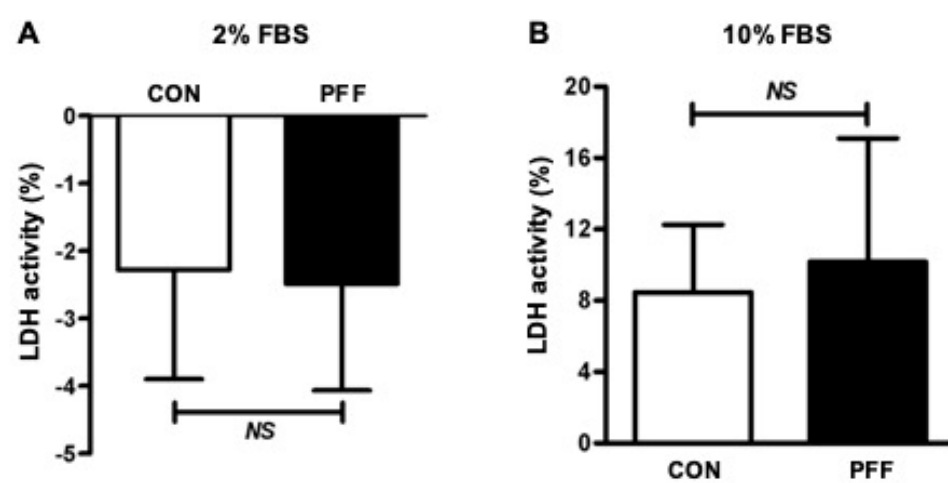
Figure A2. Lack of cytotoxic e ff ect of di ff erent culture media before and after PFF on MC3T3-E1 osteoblasts as measured by lactate dehydrogenase activity. ( A ) Before PFF treatment, LDH activity of MC3T3-E1 osteoblasts in α -MEM containing 2% FBS for 1 h; ( B ) After PFF treatment, LDH activity of MC3T3-E1 osteoblasts without and with PFF in α -MEM containing 10% FBS for 1 h. NS: No significance. LDH, lactate dehydrogenase; FBS, fetal bovine serum; CON, control; PFF, pulsating fluid flow. Appendix A.2